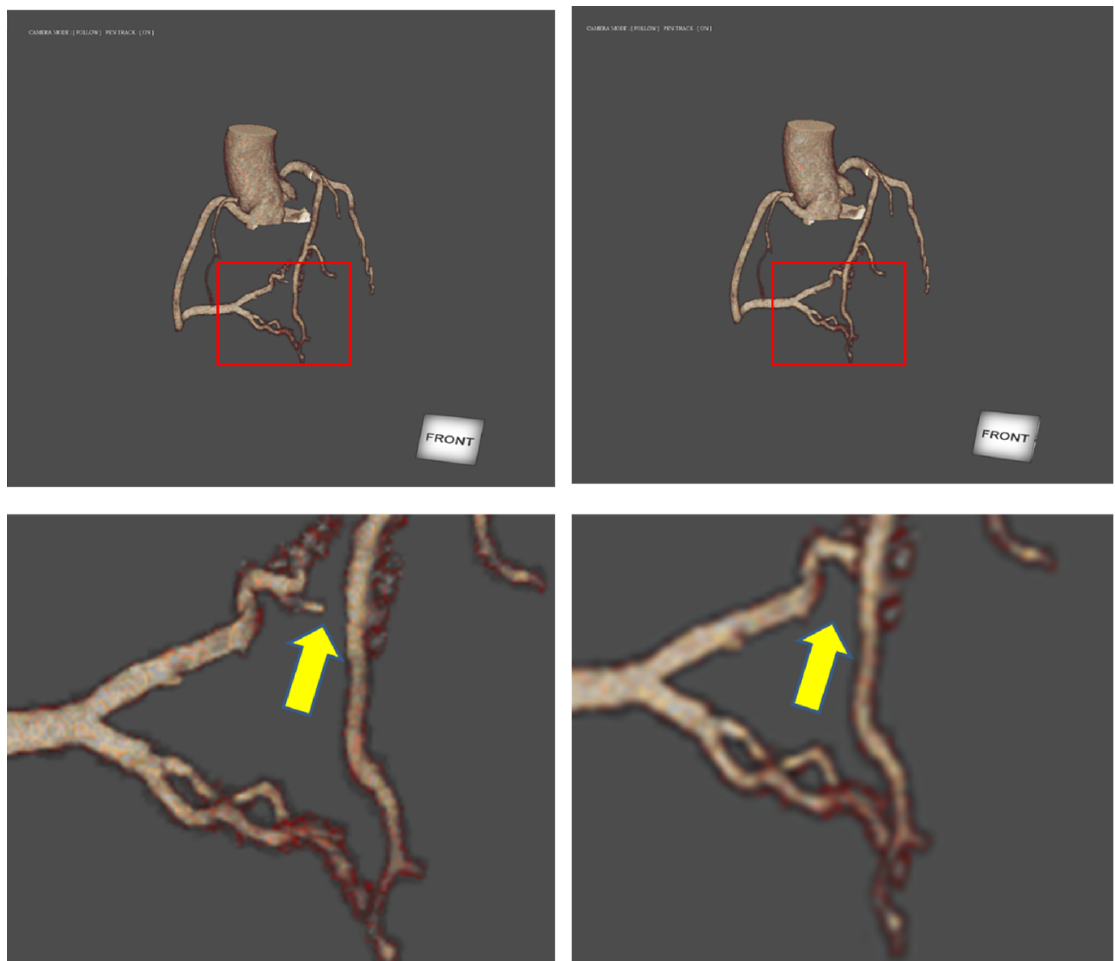
Figure 14. Example of the augmented morphological information provided by the proposed 3D display system. The 1st row shows the left and right views from the 3D display prototype. The 2nd row shows an enlarged region of interest (red box, 1st row), and clearly highlights the improvement provided by the proposed system with respect to deciphering the morphology of coronary arteries: the left image shows separate arteries, whereas the right image shows overlapping information. The user receives both images to both eyes; therefore, they experience enhanced 3D depth perception and access more morphological information compared to 2D displays.